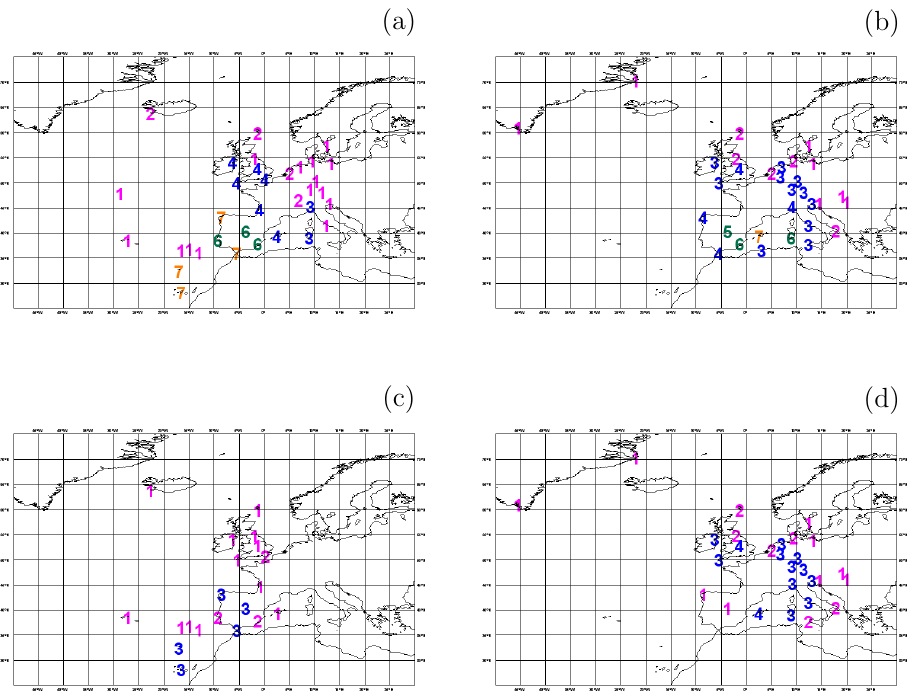
Fig. 3. Number of additional radiosondes deployed for all 2008 (a) and 2009 (b) events, and for event c (c) and event f (d) . Coloured number: 1–2 (violet), 3–4 (blue), 5–6 (green), and 7 or more (orange)